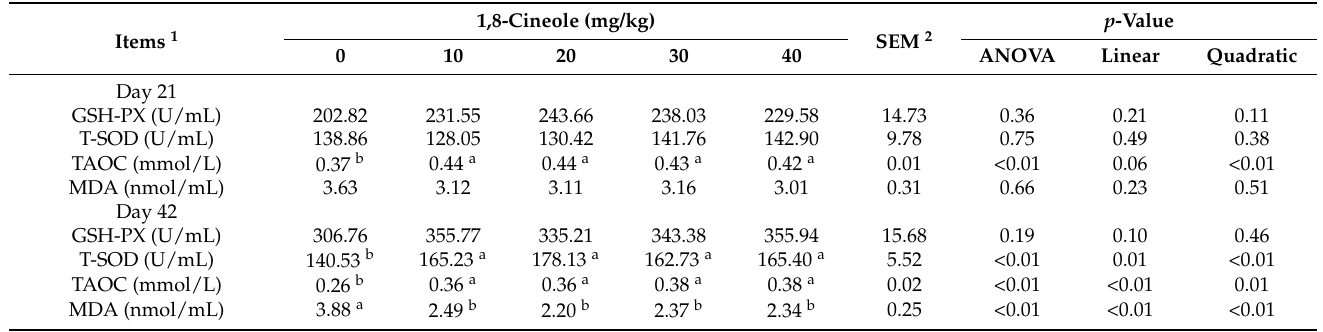
Table 3. Effects of dietary 1,8-cineole supplementation on antioxidant capacity of broiler chickens in serum.